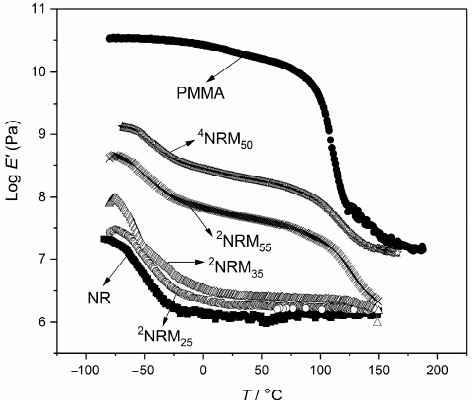
Figure 5. Storage modulus of semi-IPNs and homopolymers as a function of temperature.